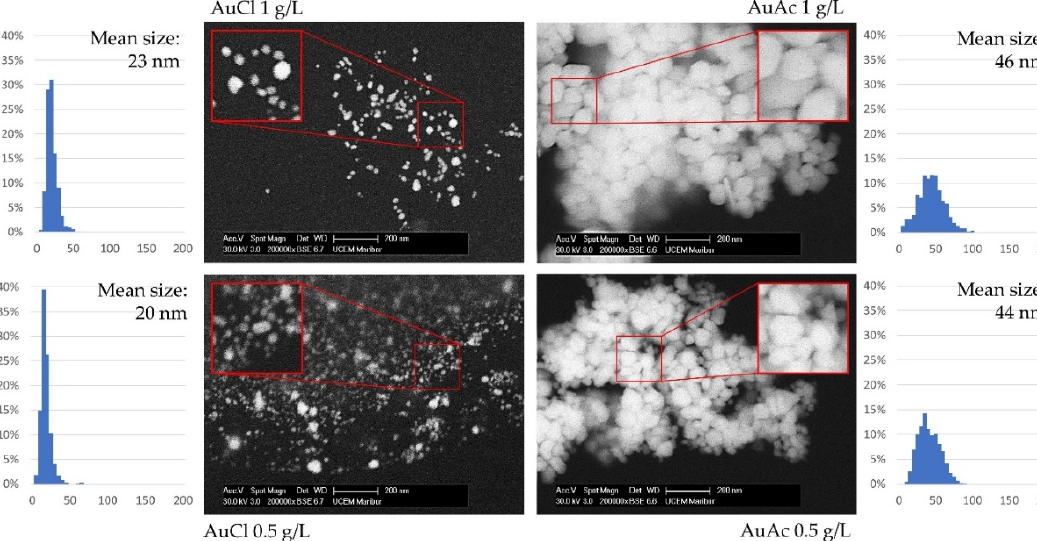
Figure 7. SEM micrographs of AuNPs taken from filtered suspensions, with corresponding size distributions from